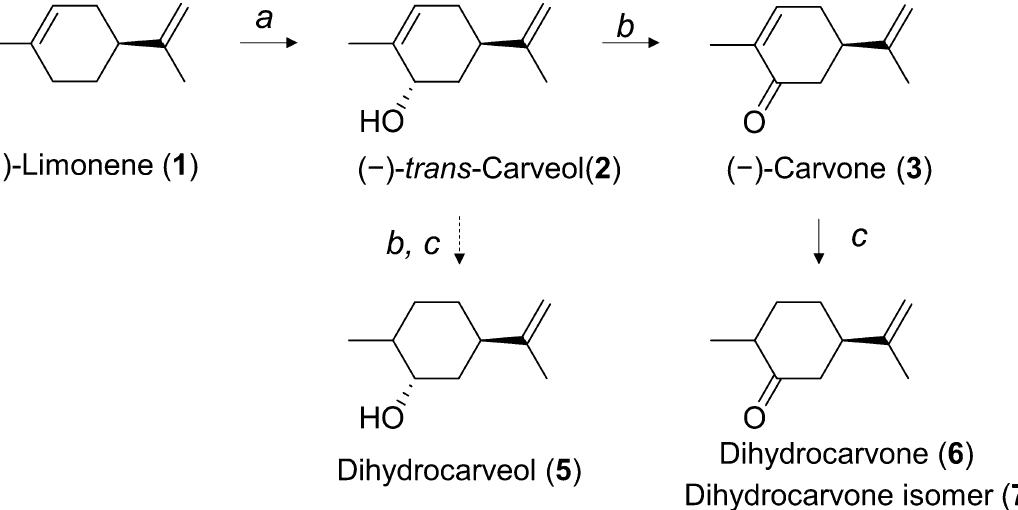
Figure 8. Hypothetical by-product formation pathway. Biosynthesis pathway of (−)-carvone from the primary precursor (−)-limonene. The indicated enzymes are ( a ) cytochrome P450 limonene-6-hydroxylase, ( b ) carveol dehydrogenase, and ( c ) an unknown endogenous